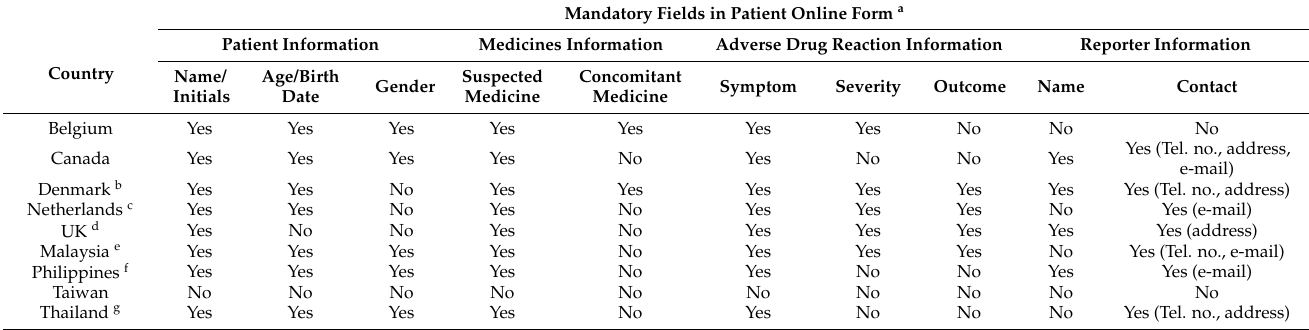
Table 7. Characteristics of patient online form.